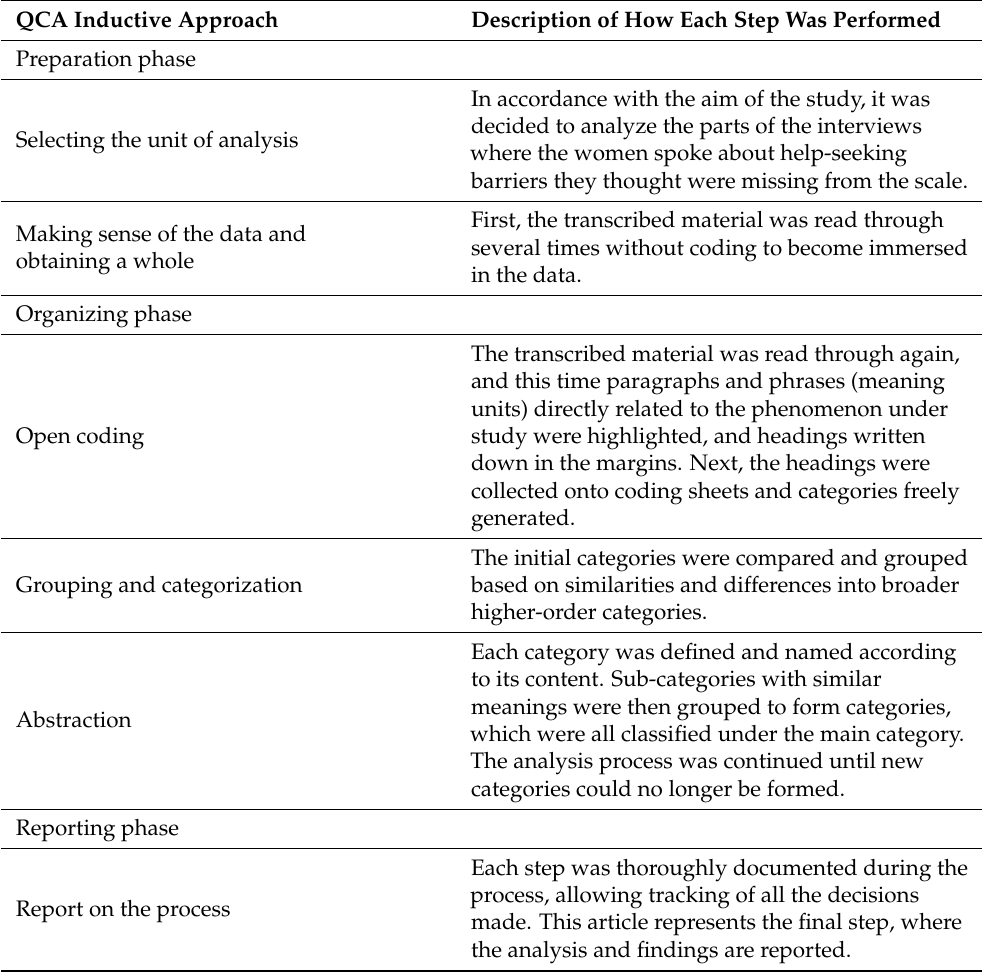
Table 2. Overview of the content analysis process, based on Elo and Kyngäs